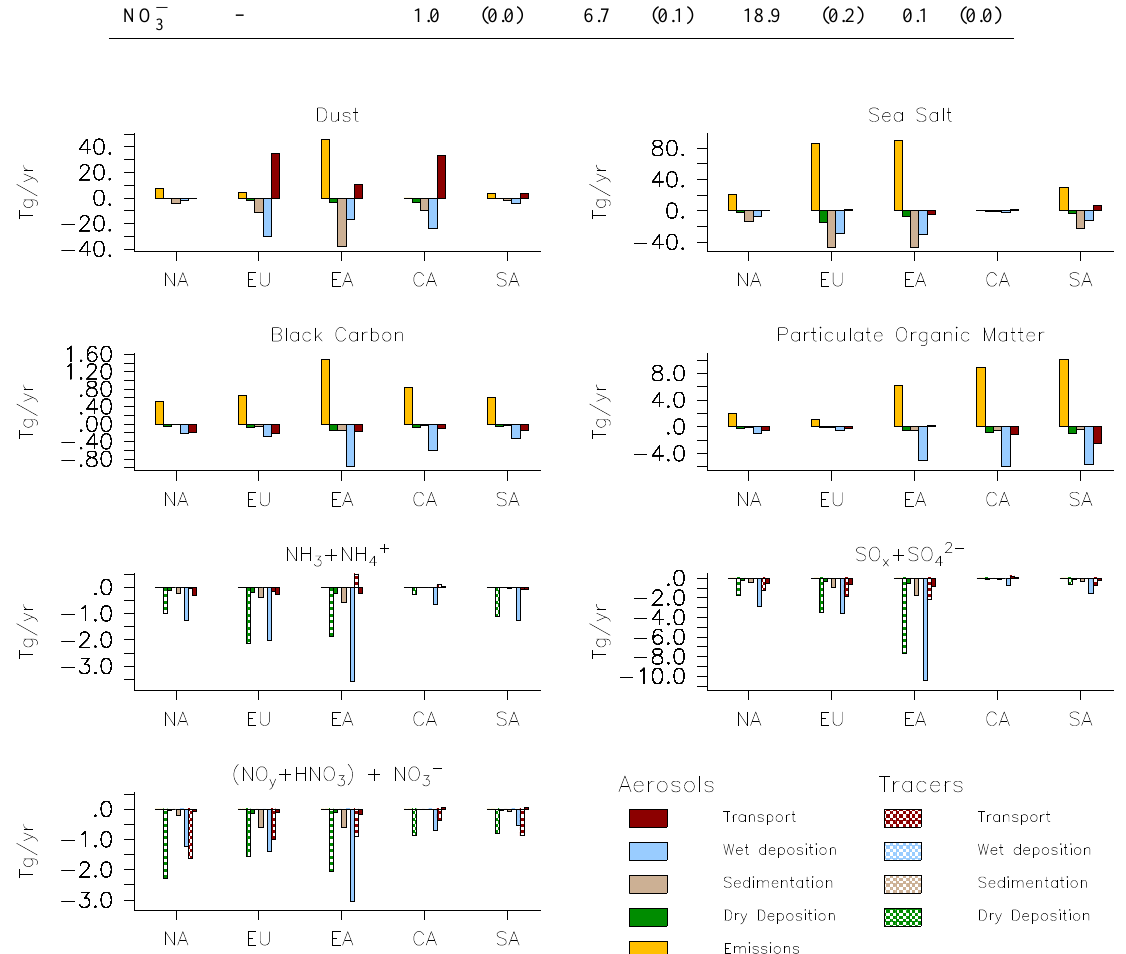
Fig. 14. Budget of different aerosol (and precursors) species as in Table 5. The colour code denotes the process, while the positive (negative) value is associated with a source (sink) of the component. Under the abscissa the regions are listed: North America (NA), Europe (EU), East Asia (EA), Central Africa (CA) and South America (SA). For non bulk species the gas-phase and aerosol contribution to the budget are also shown with dashed and solid colour bars, respectively. For the non bulk aerosol species the emissions were removed for